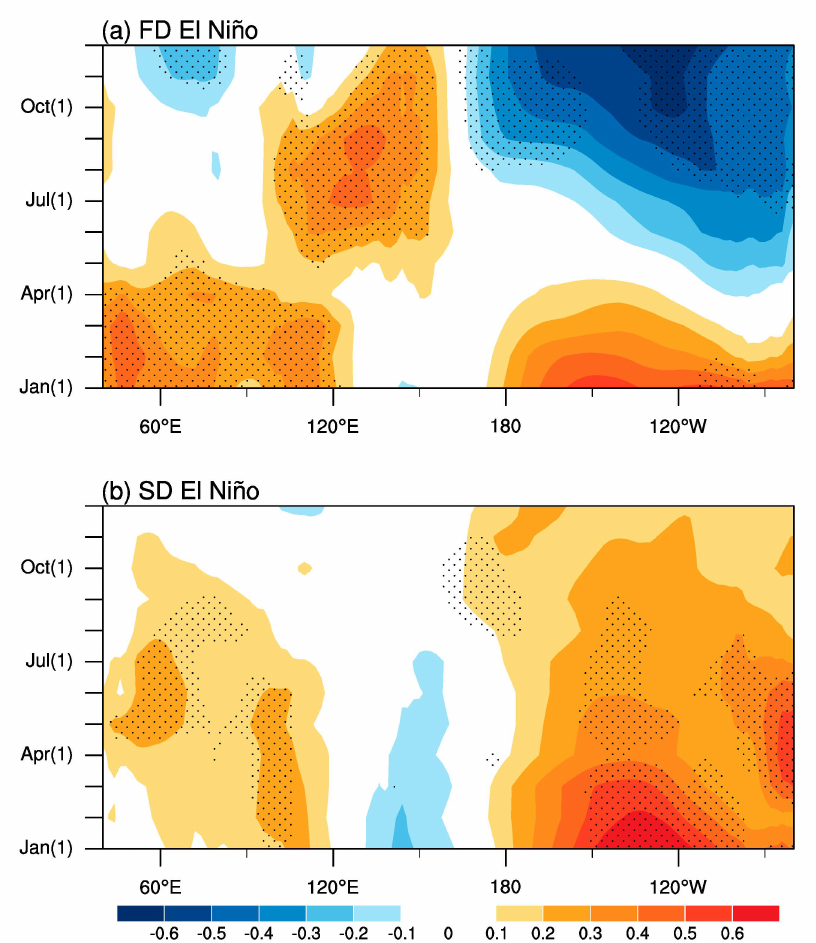
Figure 4. Temporal evolution of SST forcing in ( a ) FD El Niño years and ( b ) SD El Niño years averaged over the 20 ◦ S–20 ◦ N